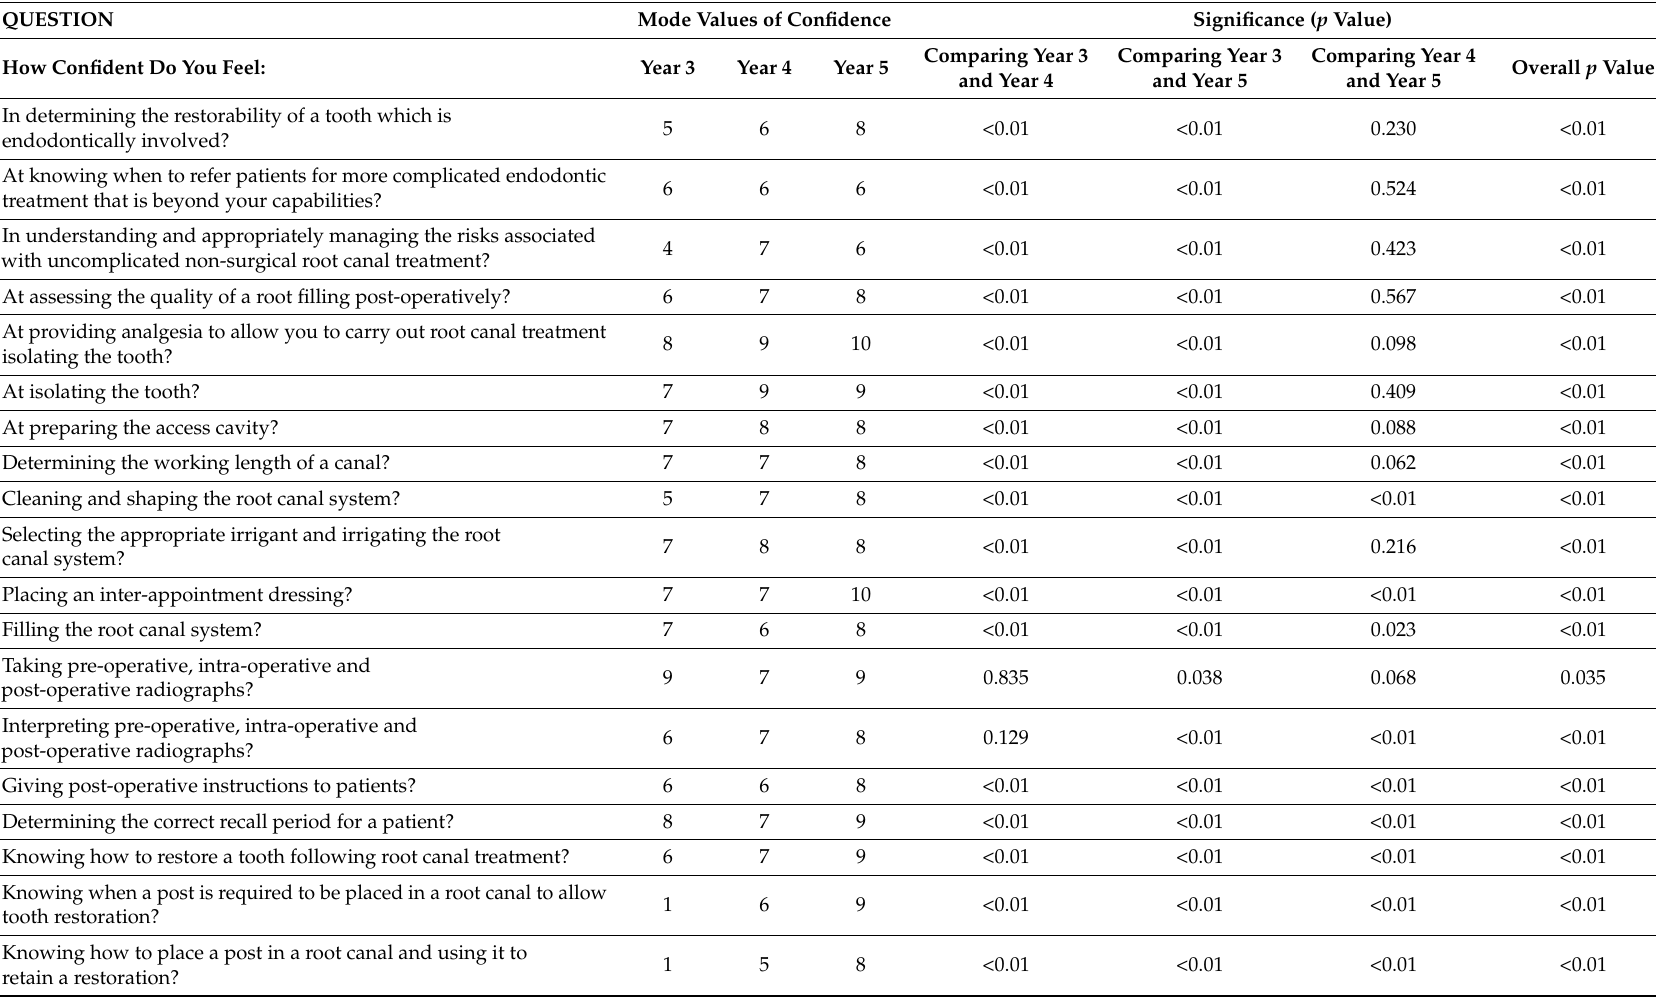
Table 3. Students’ perception of confidence when performing each stage of uncomplicated